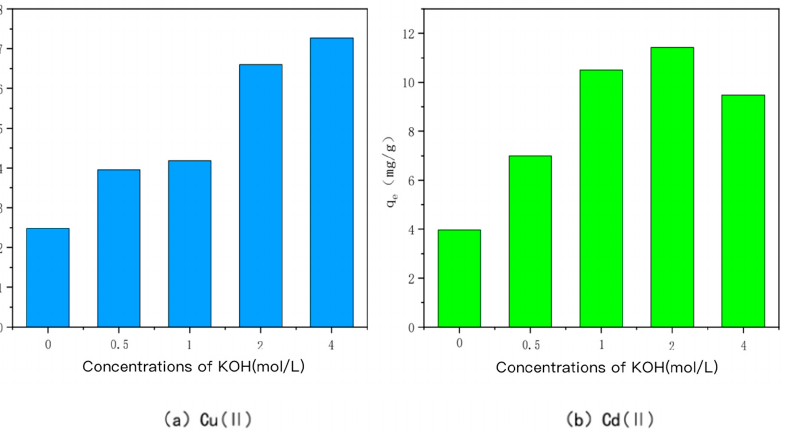
Figure 2. The adsorption capacity of Cu(II)/Cd(II) adsorbed by KOH-modified carbon at different concentrations of KOH.